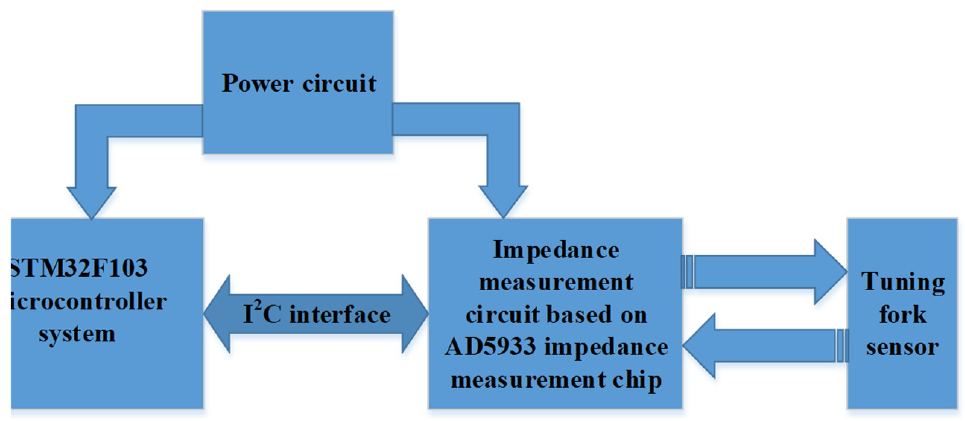
Figure 3. Design of hardware circuit of the measurement system.